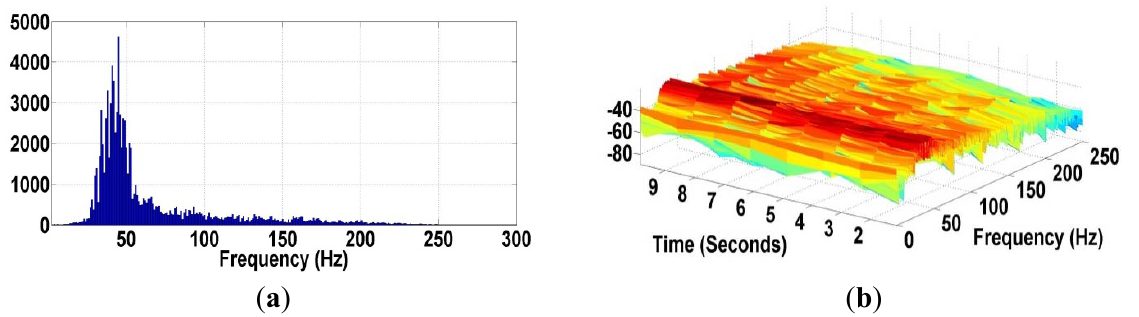
Figure 9. ( a ) Frequency Content of Wireless Sensor Signal using FFT; ( b ) Segmentation of Wireless Sensor Signal using